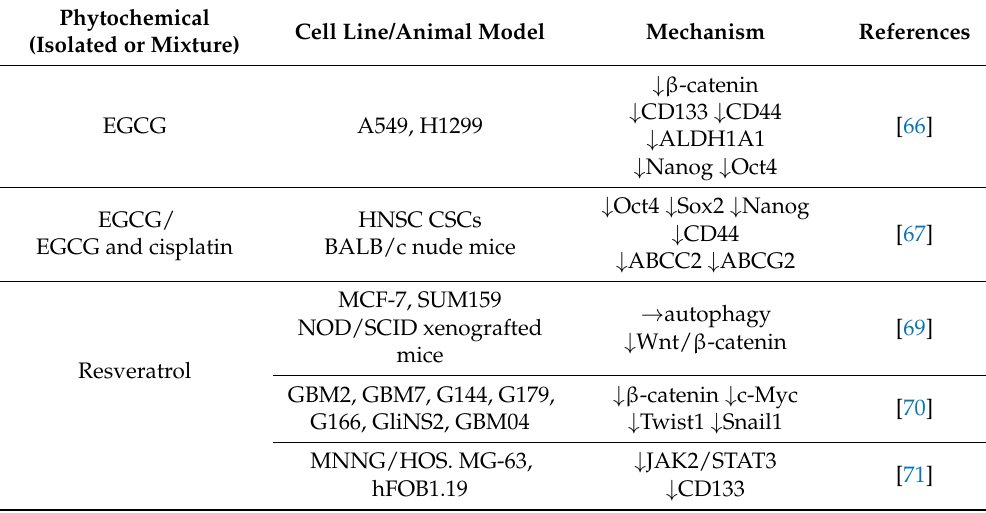
Table 3. Anticancer mechanisms of dietary phytochemicals (isolated or mixtures) targeting